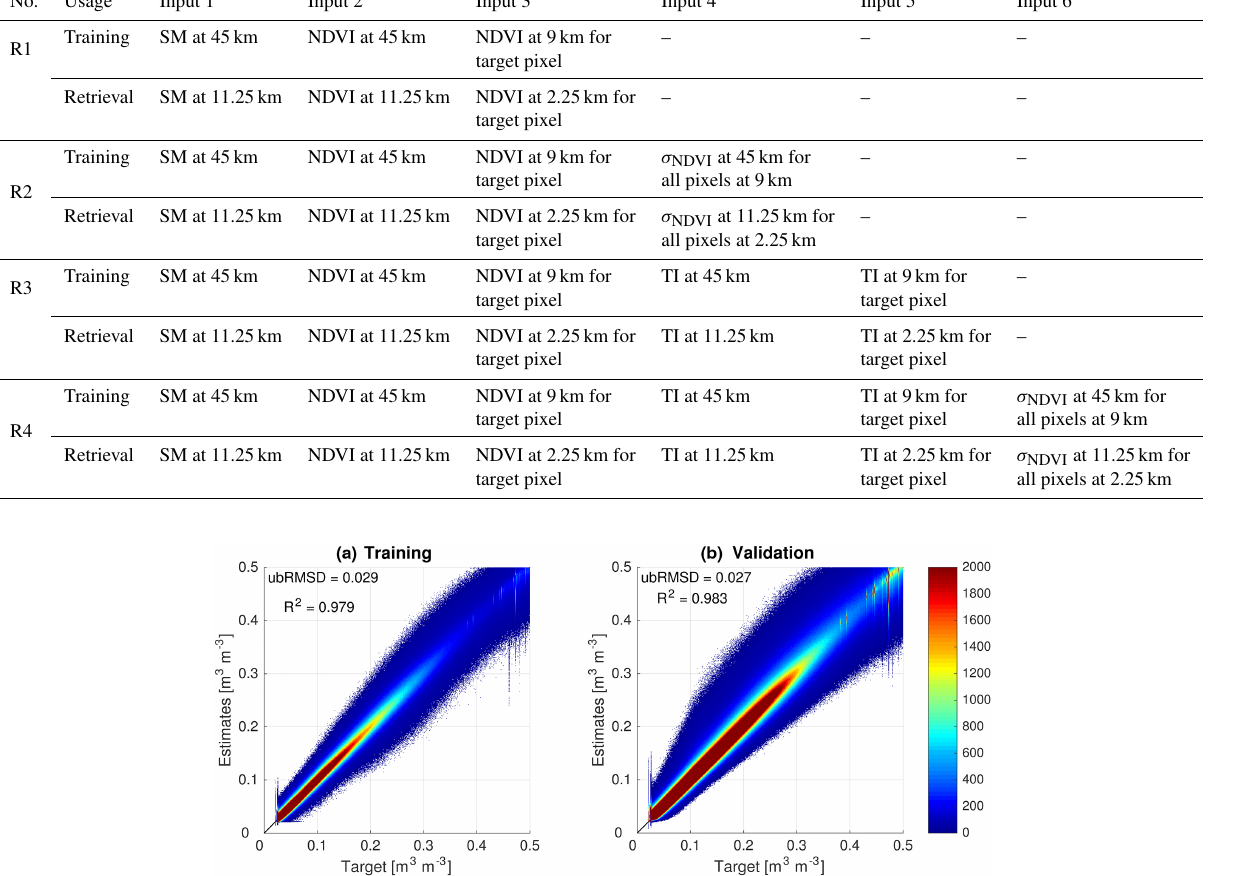
Figure 2. Density scatterplot of NN estimates versus target data for training (a) and validation (b) datasets. Color shades show the number of samples in each part of the